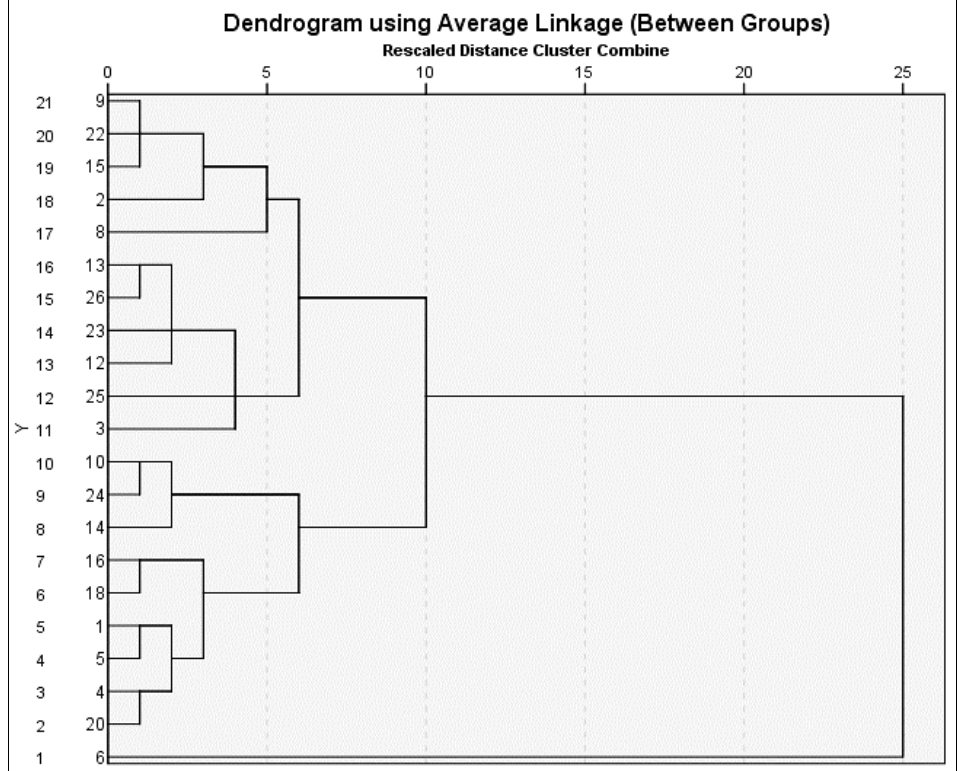
Figure 2. Cluster Analysis